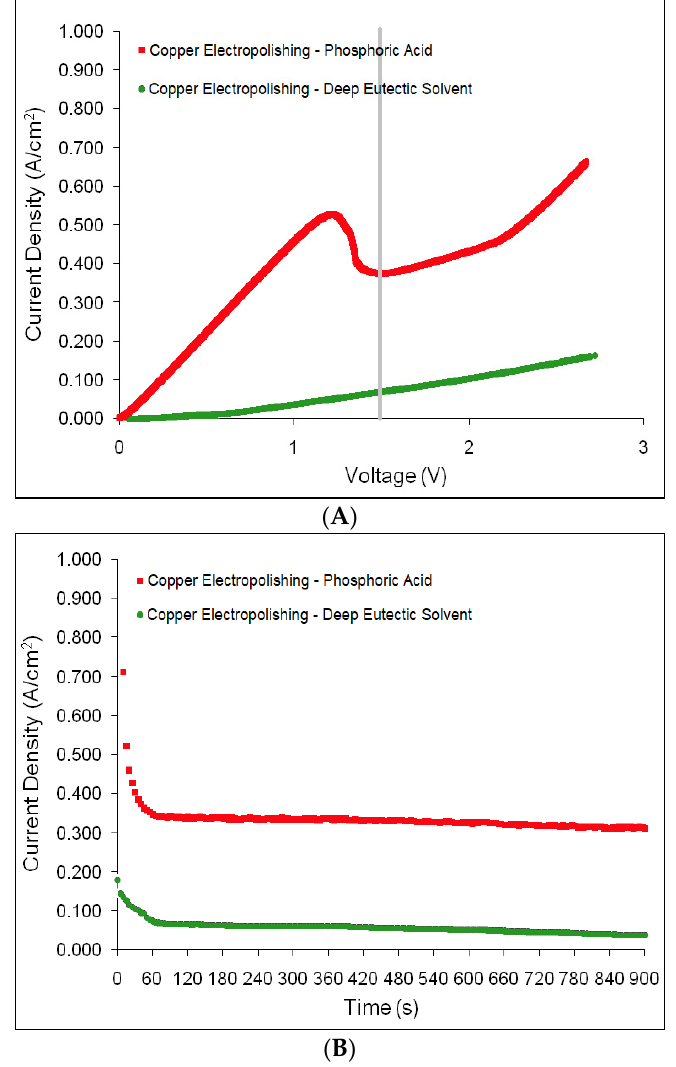
Figure 1. Schematic diagram of anodic leveling of high-purity copper surfaces via AFM at different phases of the study: ( A ) before electropolishing, and ( E ) after electropolishing treatments with the deep eutectic solvent, with representative 2D surface profiles depicted ( B ) before, ( C ) during and ( D ) after experiments. Presence of (CH (cid:2871) ) (cid:2871) NCH (cid:2870) CH (cid:2870) OH , the choline chloride radical, and Cu 2+ are abbreviated in ( C ). AFM Z -axis = 100 nm/div.